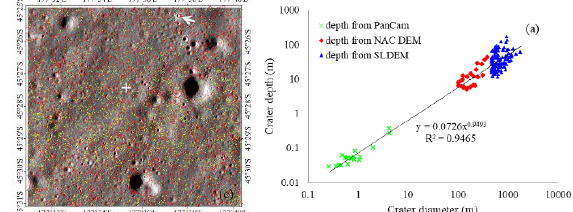
Figure 5. Left: The mapped craters in the 3.2 km×3.0 km area surrounding the CE-4 landing point. Right: The relationship between the diameter and the depth of craters. (Jia et al.,